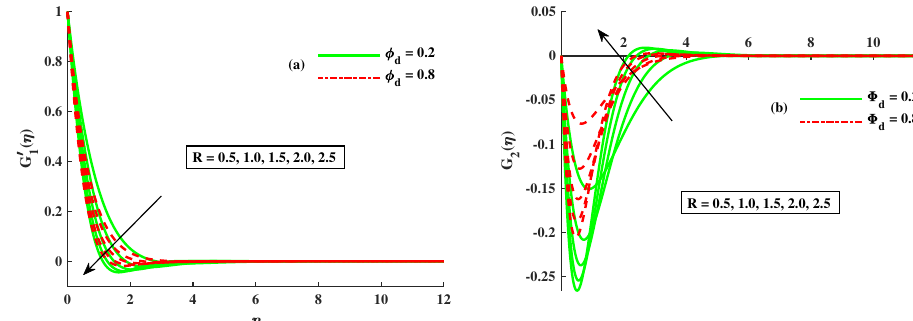
Figure 3. Fluctuation of R and φ d on G (cid:48)